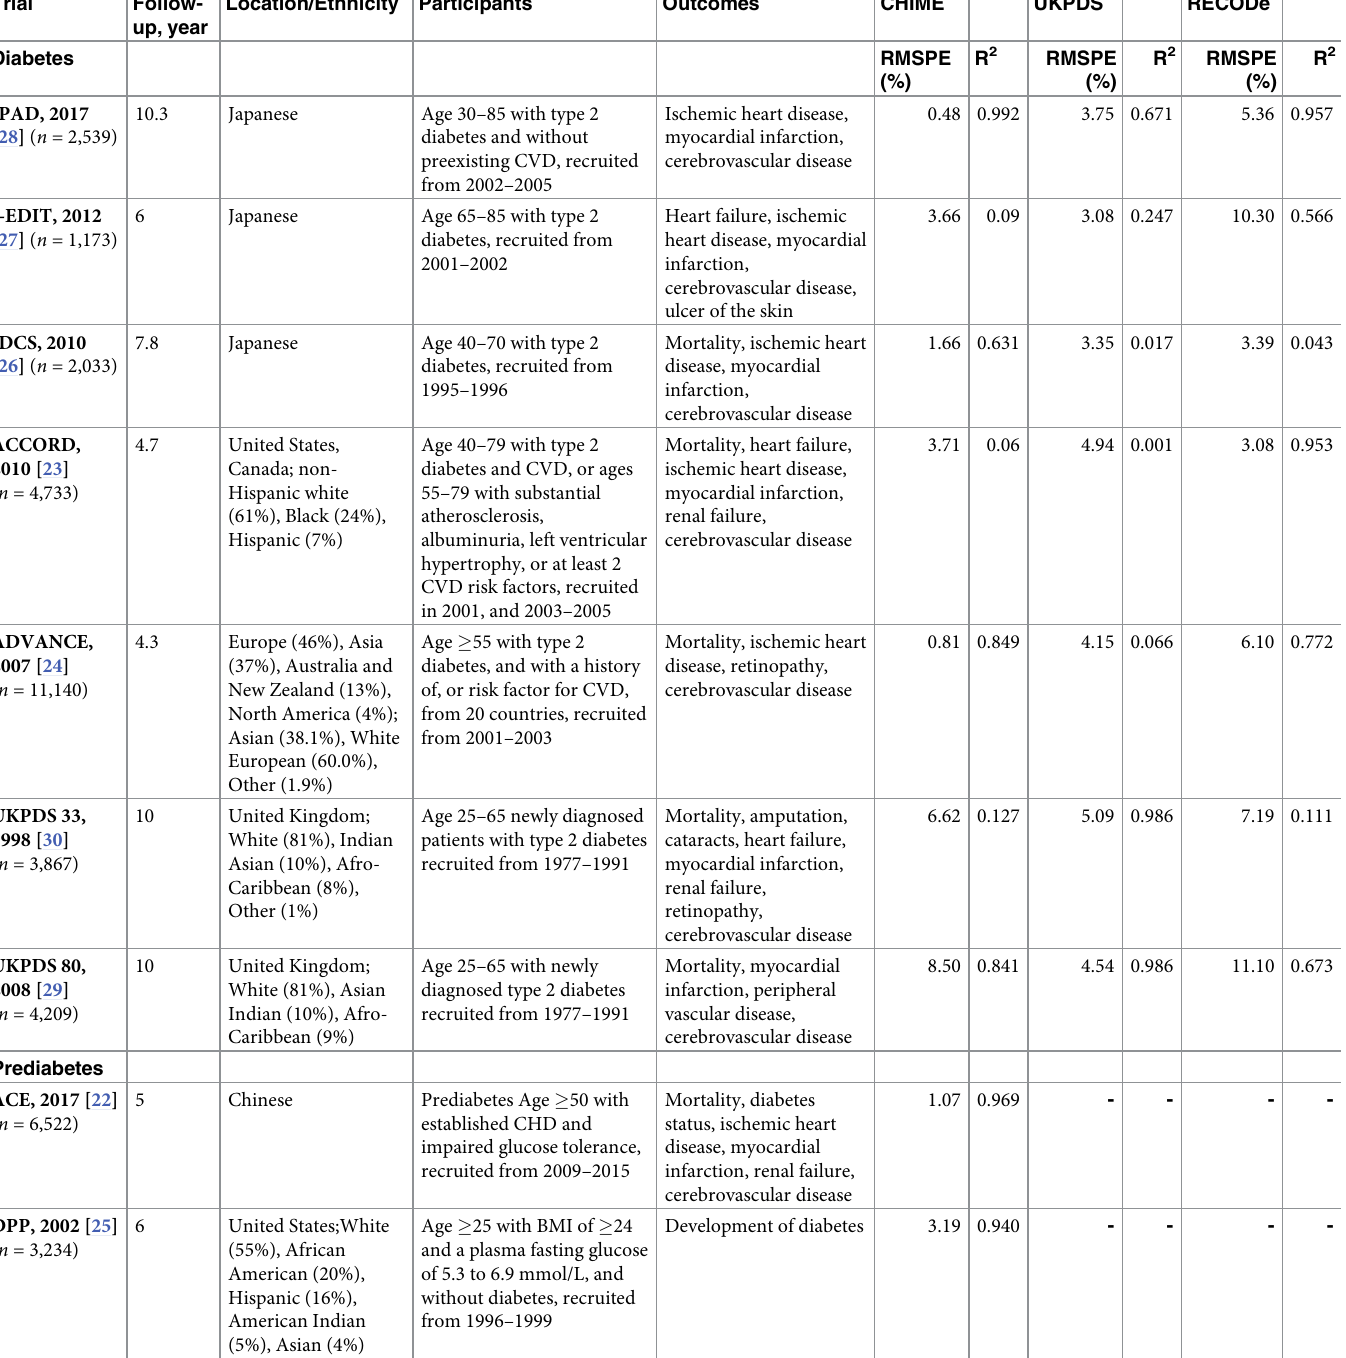
Table 3. Validation of CHIME, UKPDS-OM2, and RECODE models against simulated cohorts from trials. Trial Follow- Location/Ethnicity up, year